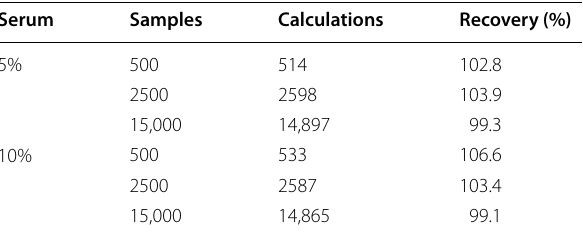
Table 1 Recovery assay to test the performance in artificial serum Serum Samples Calculations Recovery